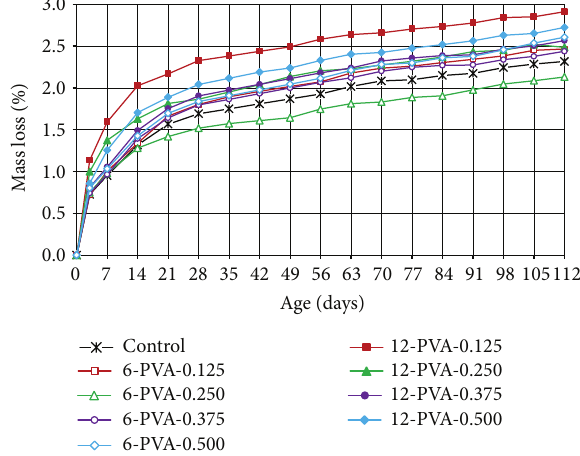
Figure 7: Shrinkage of 6mm PVA-FRC and control.